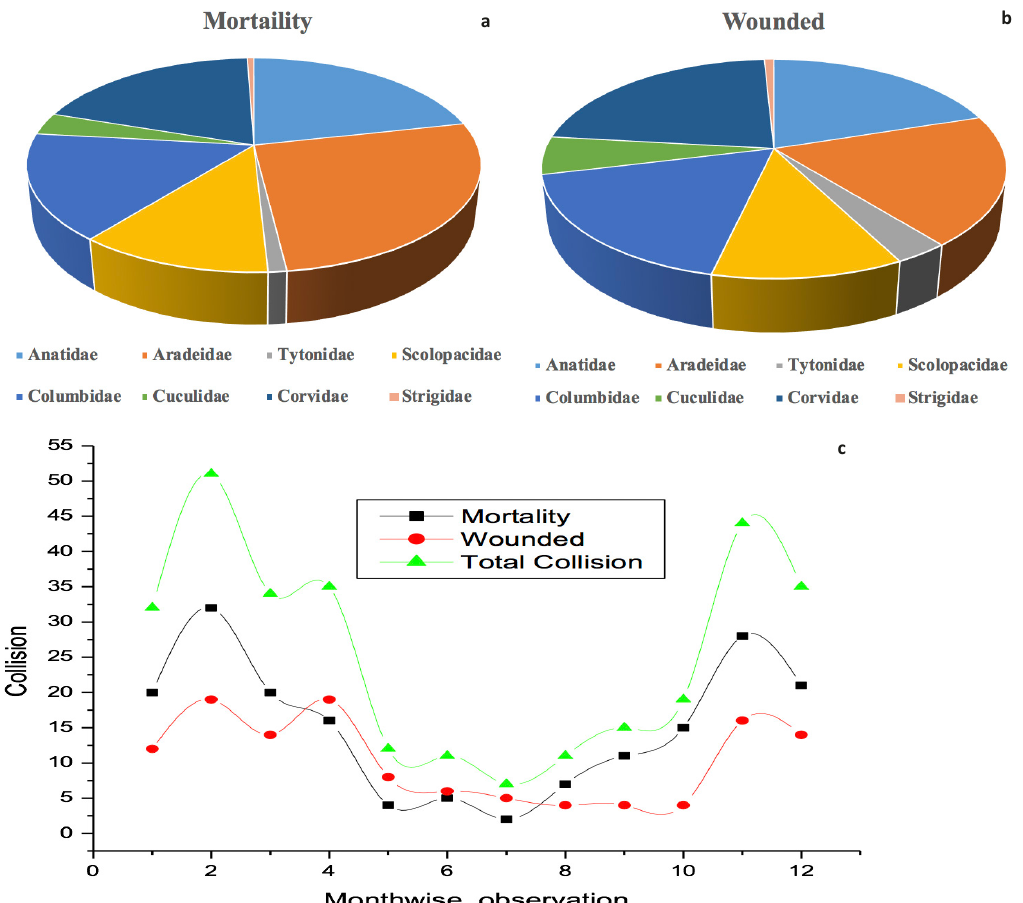
Figure 5. Records of collision of birds near Bakkhali (South 24-Parganas; West Bengal): a—family wise wounded | b—family wise mortality | c—monthwise observation between February 2017 and January